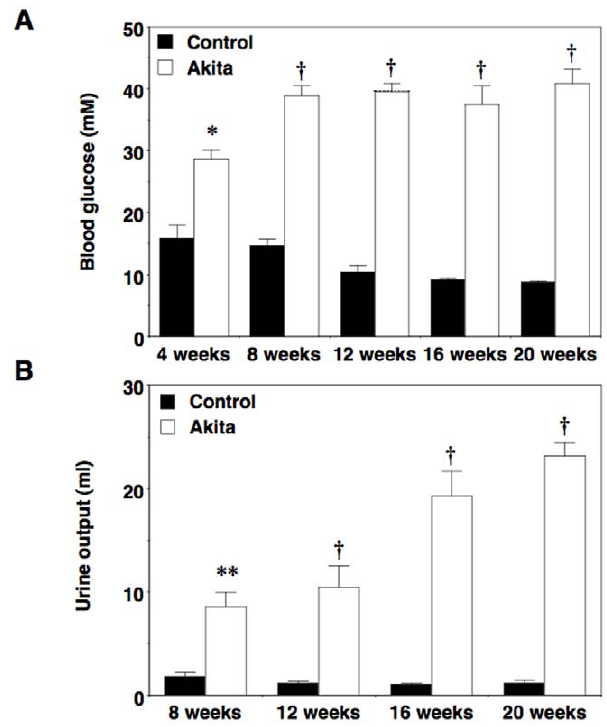
Figure 1. Fasting blood glucose levels and urine output in male Akita mice. (A) FVB/NJ- Ins2 + /C96Y mice developed sustained hypergly- cemia by 4 weeks of age, which persisted throughout the duration of the study. (B) Urine output in FVB/NJ- Ins2 + /C96Y was significantly increased by 8 weeks of age and further increased during the study period. Black bars=control (n=6 to 8); white bars=Akita (n=6 to 8). Data are mean 6 SEM. *P , 0.05 { P , 0.001 or **P , 0.01 vs. age-matched